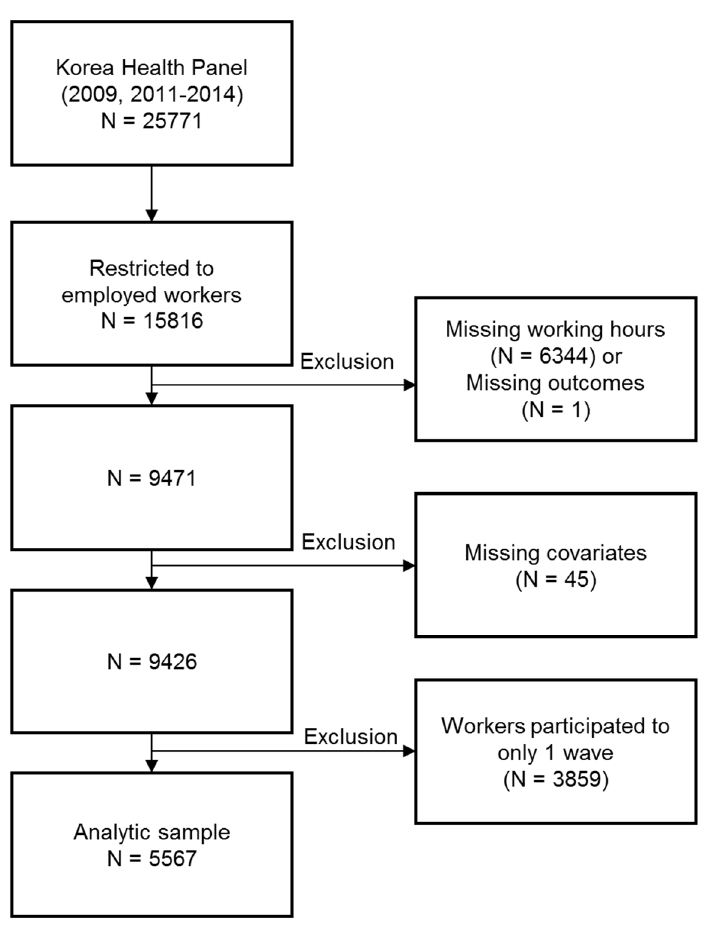
Figure 1. Flow chart of the participants selection.